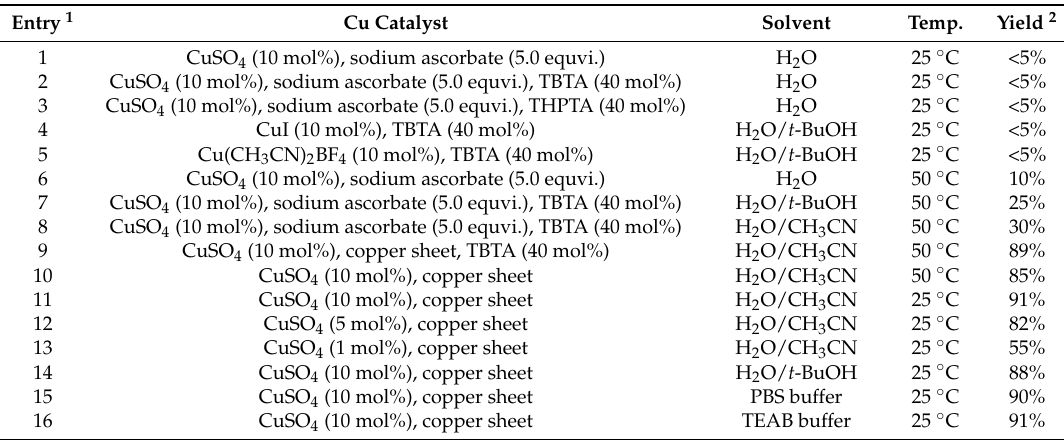
Table 1. Screenings and optimizations of reaction